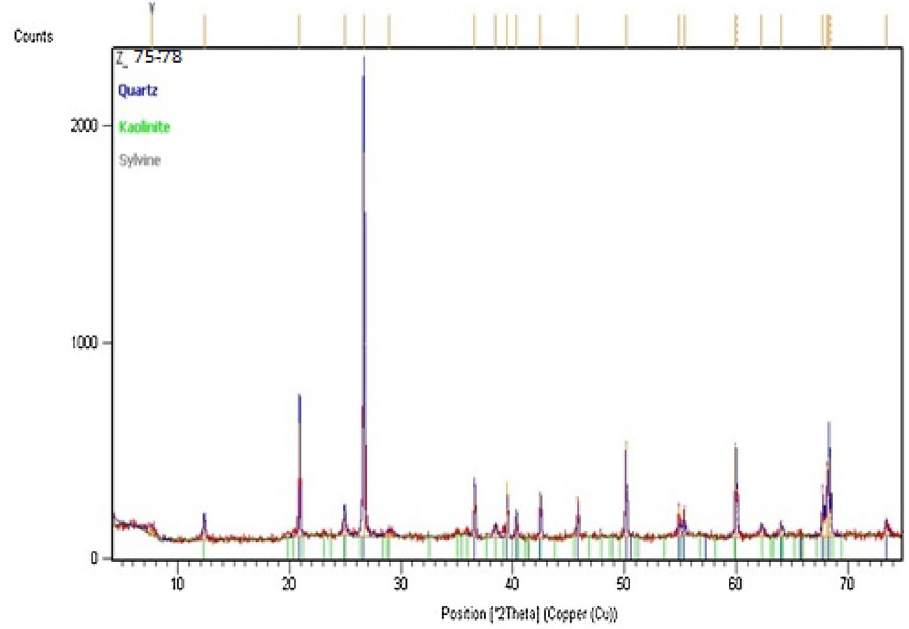
Fig. 14 XRD diffractograms of core sample from Ajegunle A4 at a depth range of 75–78